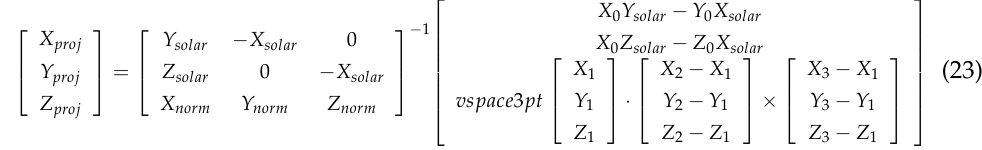
determined. Whether a PV cell at coordinates P ( X cell , Y cell , Z cell ) is in the shadow can be determined according to the relation of the four vectors from the position of the PV cell to the end points of the quadrangle ( X i , Y i , Z i ) , i = 1, 2, 3, 4, as shown in Figure